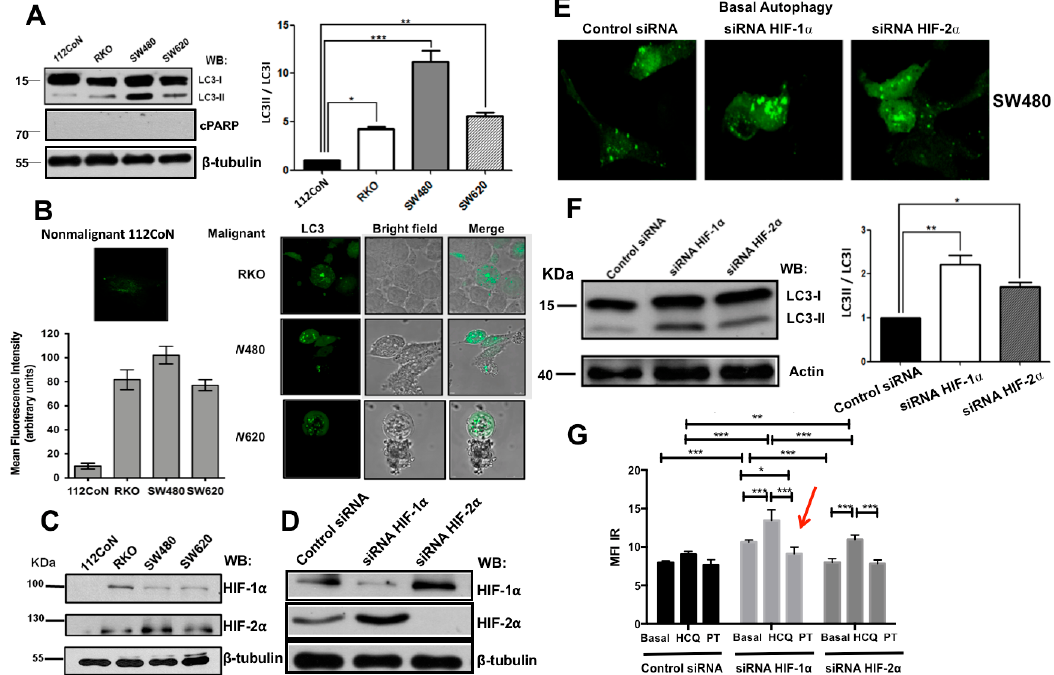
Figure 1. ( A ) RAS-driven and BRAF-driven human colon cell lines show higher levels of basal autophagy than non-malignant cells. The expression of the ratio LC3II/I was examined in colon non-malignant 112CoN or colon malignant RKO, SW480, and SW620 cells by Western blotting. The β -tubulin antibody was used to control for equal loading. Densitometric analysis was performed to estimate the changes in LC3II7LC3I ratio levels in cancer cells compared with 112CoN non-malignant colon cells; the bar graphs represent the means ± standard error of the mean (SEM) from at least three independent assays. * p < 0.05; ** p < 0.01; *** p < 0.001. ( B ) Colon non-malignant 112CoN or colon malignant RKO, SW480, and SW620 cells were transiently transfected with an EGFP-LC3 -expressing plasmid and grown in normal medium. Twenty-four hours after transfection, the cells were visualized by the presence of LC3 puncta under the confocal microscope (Leica TCS SP5) with a krypton-argon laser. The images (40 × ) were analyzed for quantification with the Image J program. Data shown are representative of three independent experiments. ( C ) Analysis of hypoxia-inducible factors (HIFs) expression in colon cancer cells compared with non-malignant cells by immunoblotting. Total cell extracts from colon cell lines were prepared, and the samples were subjected to sodium dodecyl sulfate polyacrylamide gel electrophoresis (SDS-PAGE) followed by immunoblotting using the indicated antibodies. β -tubulin was used as a control for equal loading. Data are representative of three independent